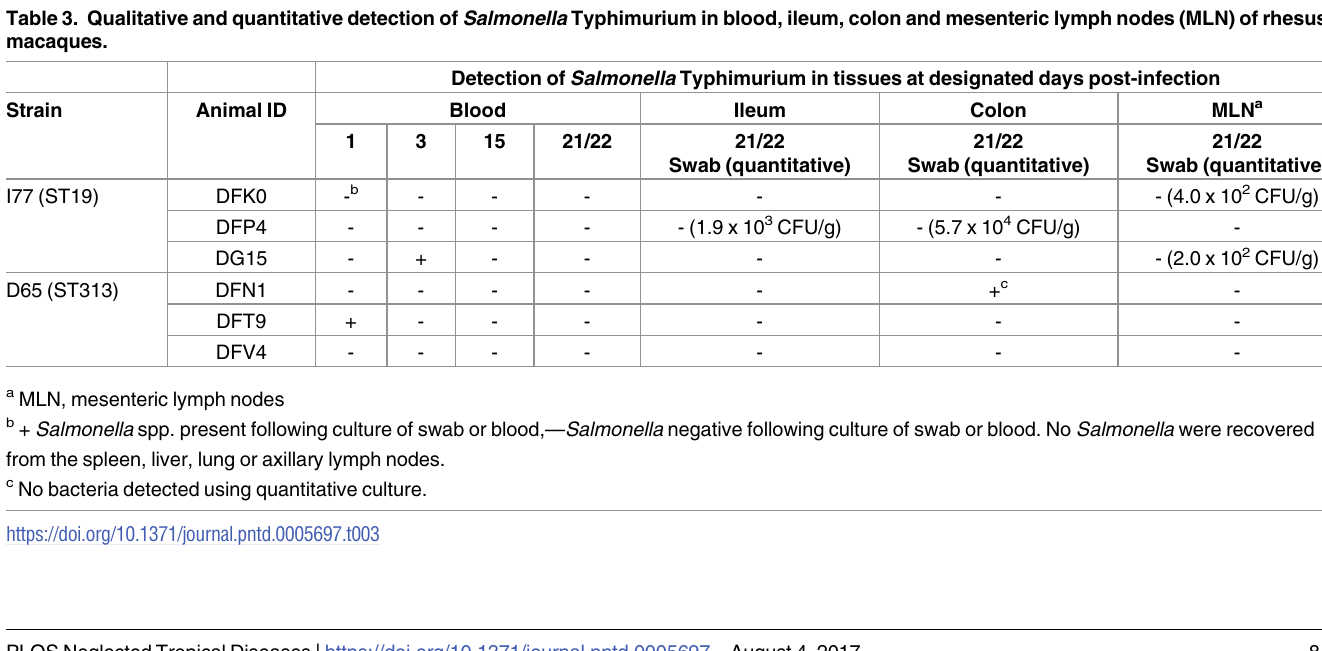
Table 3. Qualitative and quantitative detection of Salmonella Typhimurium in blood, ileum, colon and mesenteric lymph nodes (MLN) of rhesus macaques.